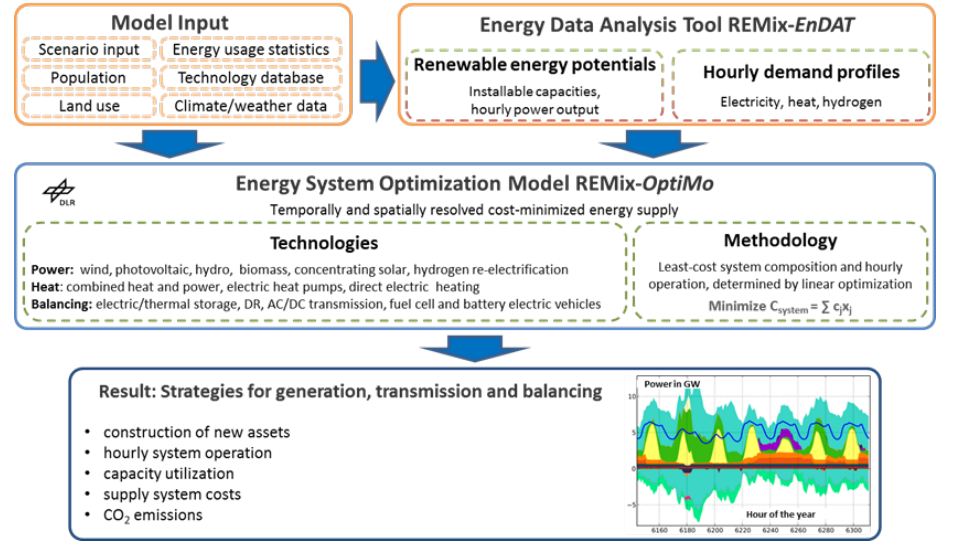
Figure 2. Overview of the REMix model structure.